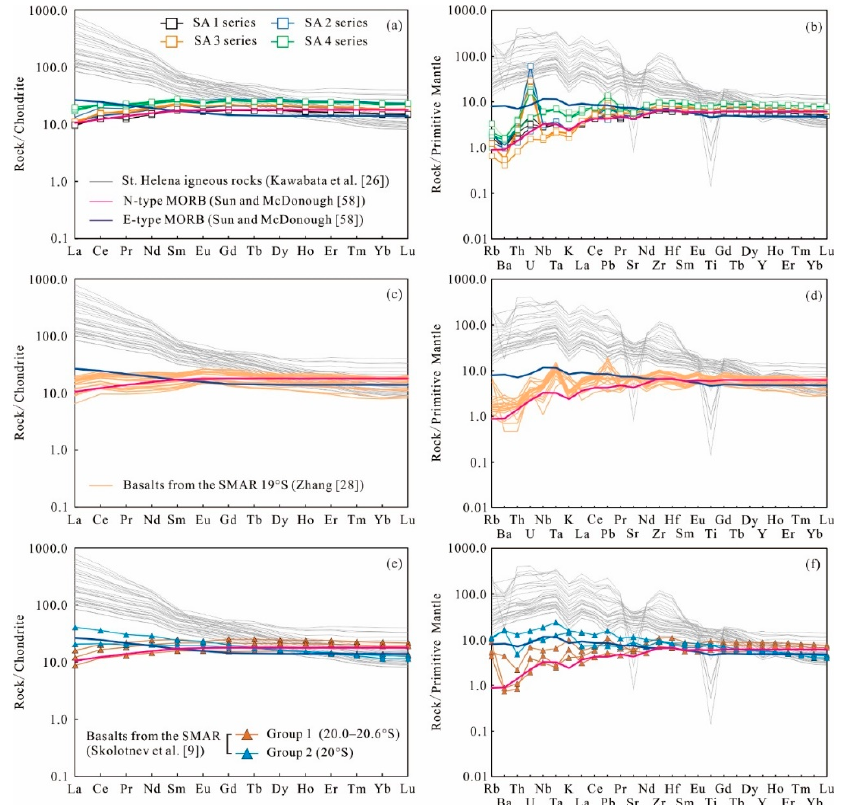
Figure 6. Chondrite-normalized REE ( a – e ) and primitive mantle-normalized multielement ( b – f ) diagrams of the basalts from the SMAR at 18–21°S. The chondrite and primitive mantle normalization data are from [58]. ( e , f ) according to Skolotnev et al. [9], the formation of the group 1 basalts resembles that of the depleted OIB associated with the melting of a mantle substrate dominated by DMM-type components and the group 2 basalts were derived from a heterogeneous mantle substrate that was linked to the mixing of DM components with HIMU-type components, which are possibly related to the spreading of mantle material of the St. Helena plume.